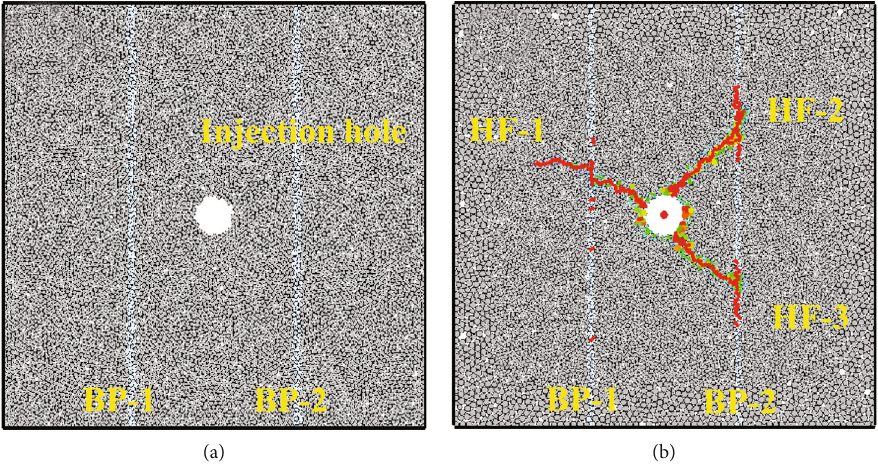
Figure 14: Group 2-2 hydraulic fracture test: (a) test block before hydraulic fracturing; (b) test block after hydraulic